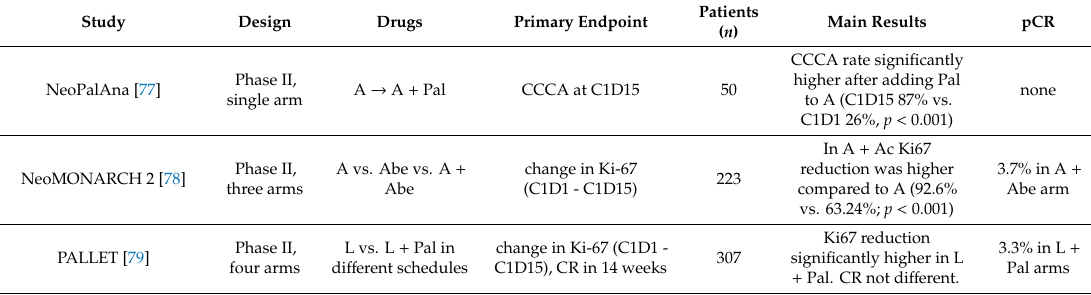
Table 2. Combination therapy with NSAI plus novel therapeutics in the neoadjuvant setting. Included patients were diagnosed with ER + , HER2- stage I-II-III